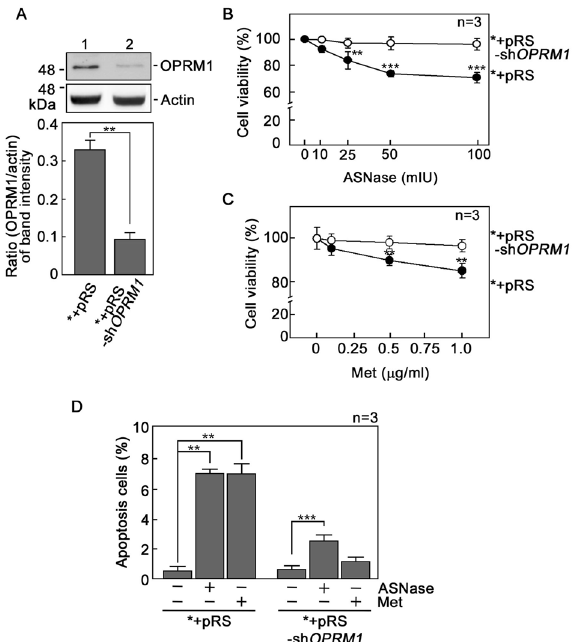
Figure 1. d,l-Methadone induces leukemic cell apoptosis through activation of OPRM1. ( A ) OPRM1 depletion (upper panel) in POETIC2 leukemic cells (*) infected with retrovirus carrying pRS-sh OPRM1 (*+pRS- sh OPRM1 ) but not in cells infected with retrovirus carrying an empty vector (*+pRS). Representative blots are from one of three independent experiments (n = 3) showing similar results. Actin blot was used as loading control. The bottom panel shows the ratios of OPRM1 vs actin levels, which were measured by densitometric analysis of the blots using NIH ImageJ 1.61. Actin levels were normalized to 1.0. Standard deviation of the OPRM1 vs actin ratio was calculated from the three sets of experiments ** p < 0.0001. ( B ) and ( C ) *+pRS- sh OPRM1 cells exhibit resistance to l-asparaginase (ASNase: B ) and d,l-methadone (Met: C ). Cells were treated with increasing concentrations of l-asparaginase or d,l-methadone for 24 h and surviving cells were quantified using Alamar blue assay. Values are means ± SEM from three independent experiments. ** p < 0.02